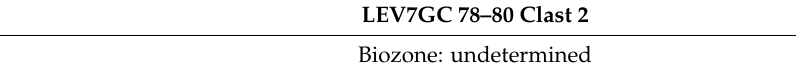
Table A36. Leipzig